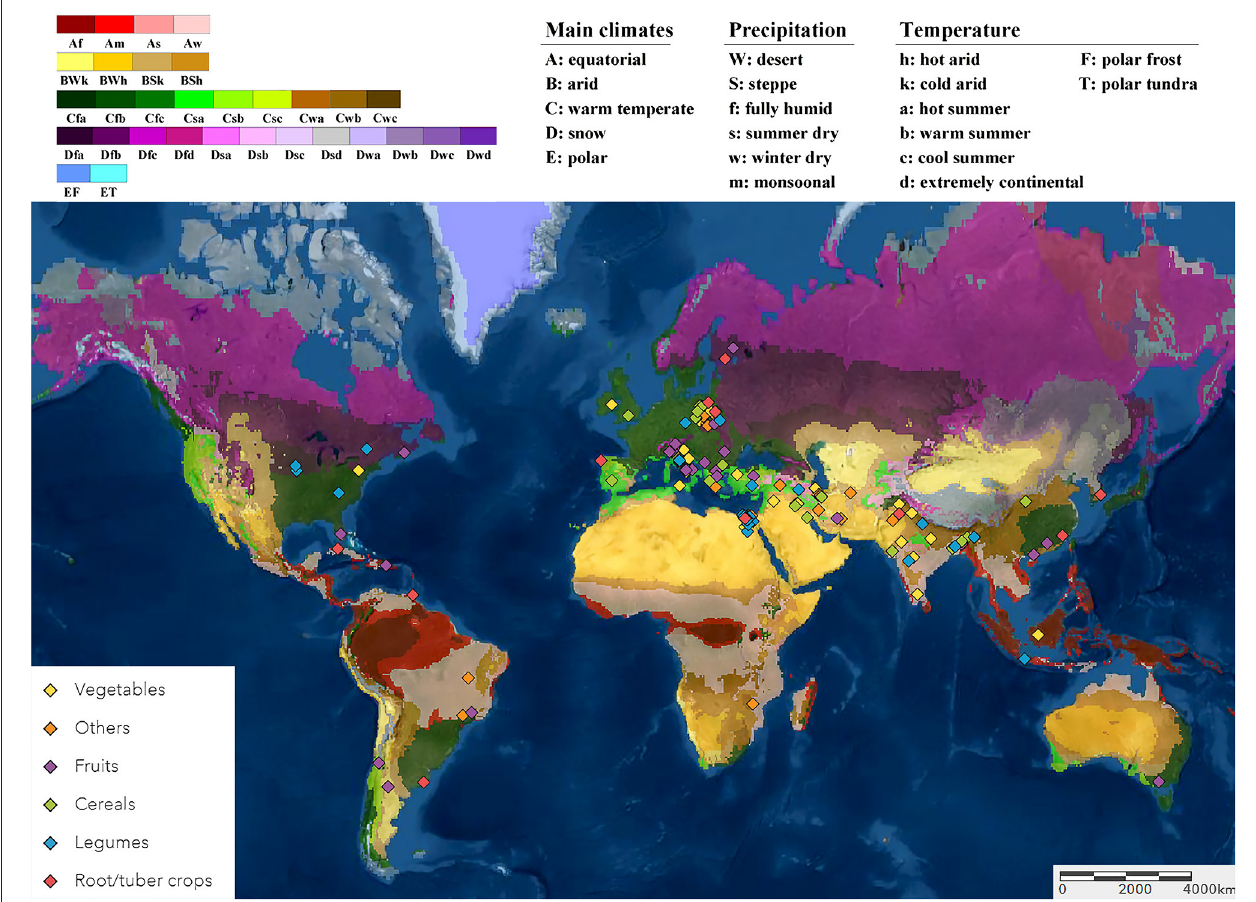
FIGURE 1 | The locations of the open-field studies included in the meta-analysis as displayed on the Köppen-Geiger climate classification (Peel et al., 2007) on the world map ( Esri, 2009). The studies were grouped based on the six crop categories of cultivation (cereals, legumes, vegetables, fruits, root/tuber crops, and other